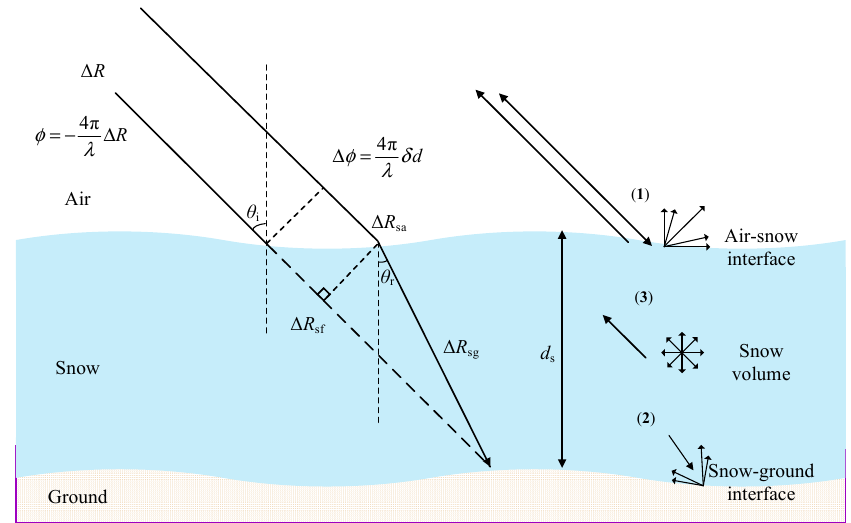
Figure 4. The geometry of the radar wave in dry snow, modified after Varade et al. [23]; ( 1 ) shows the geometry corresponding to the air-snow interface, ( 2 ) shows the refraction in the snow volume and the corresponding effect on the range, and ( 3 ) shows the range corresponding to the snow-free case.